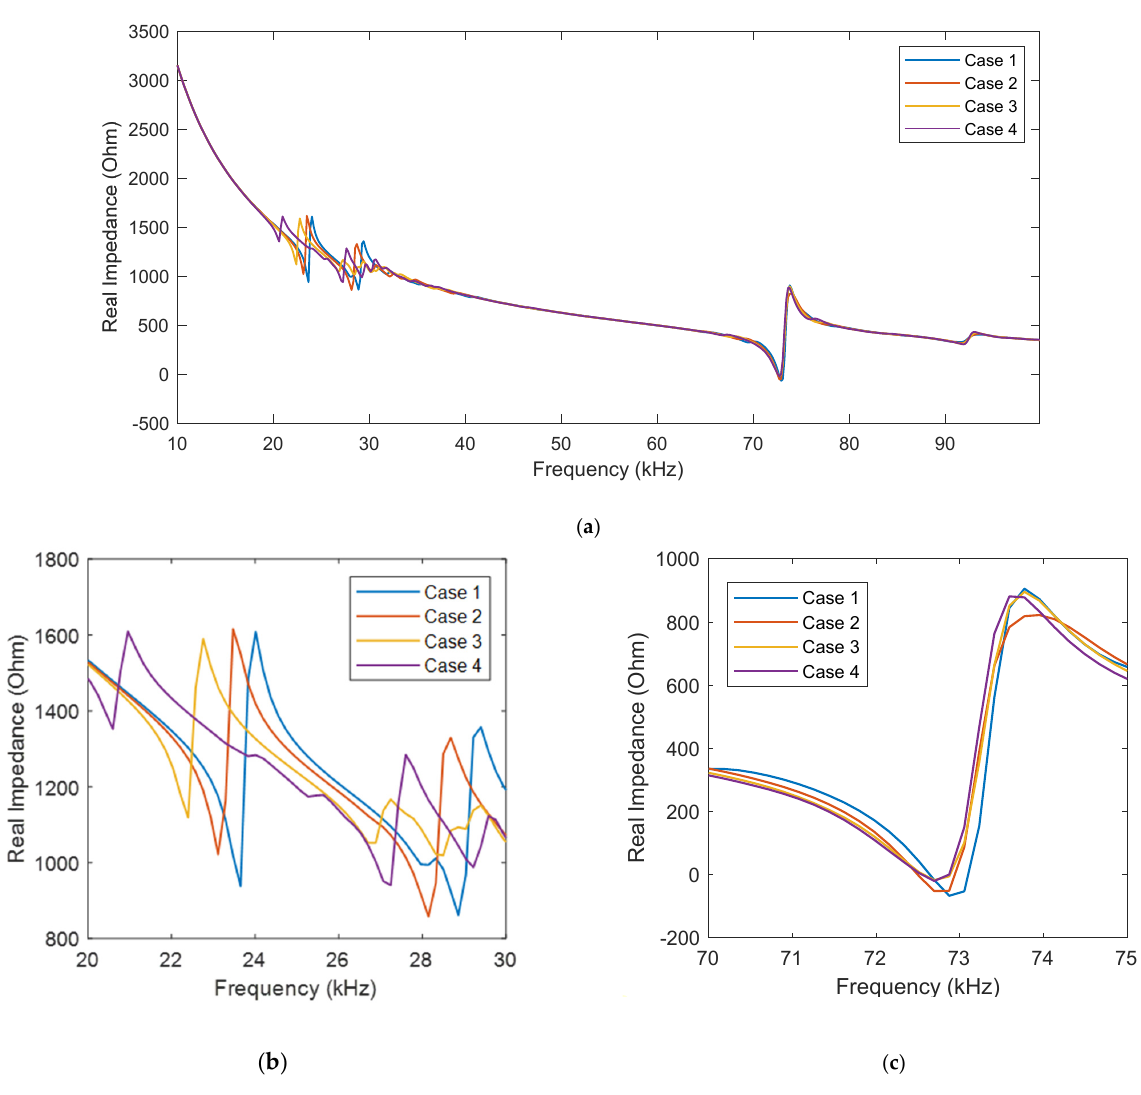
Figure 9. The imaginary part of the numerical impedance signatures for different cases of contact stiffness. ( a ) 10–100 kHz; ( b ) 20–30 kHz; ( c ) 70–75 kHz.